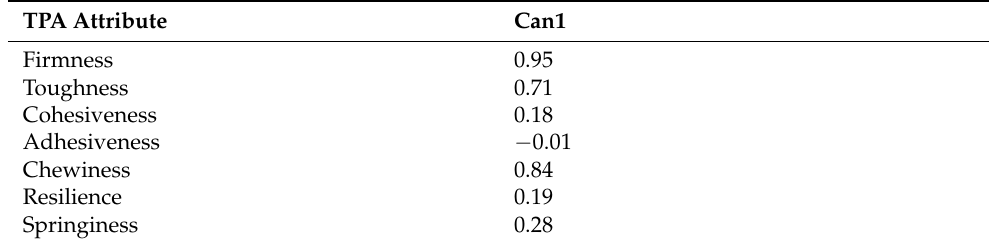
Table 5. Pooled within canonical structure ( n = 119) 1 .